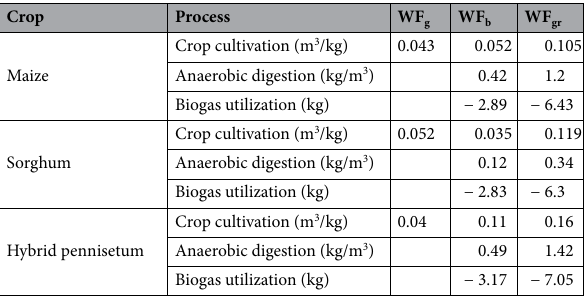
Table 3. WF results from three